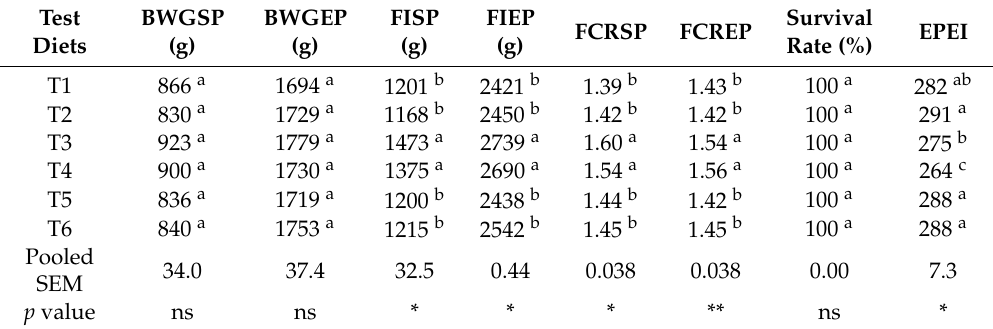
Table 4. Body weight gain, feed intake, and feed conversion ratio of broiler chickens (g / bird) fed di ff erent levels of non-degraded and degraded date